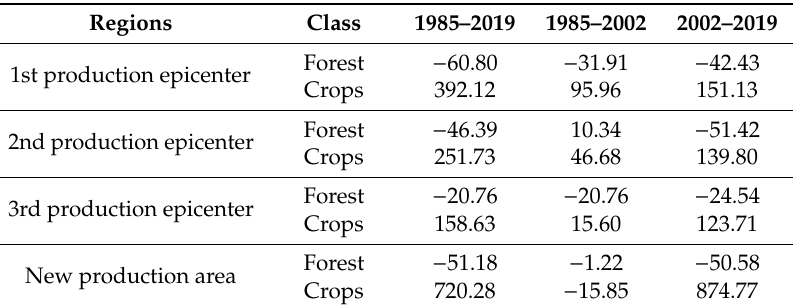
Table 5. Rate of change in forest and crop